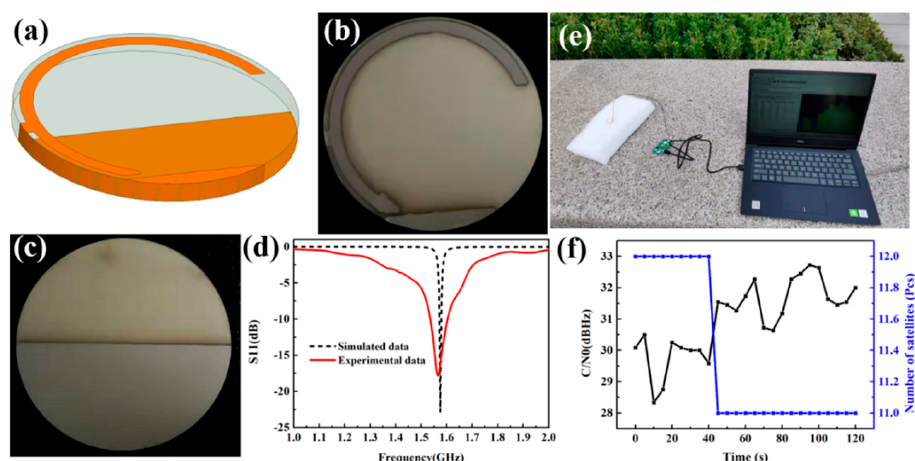
Figure 7. GPS antenna application. ( a ) Designed sample, ( b ) front face of the GPS antenna, ( c ) back face of the GPS antenna, ( d ) return loss (S11), ( e ) experimental process of GPS signal, and ( f ) C/N0 and number of satellites.